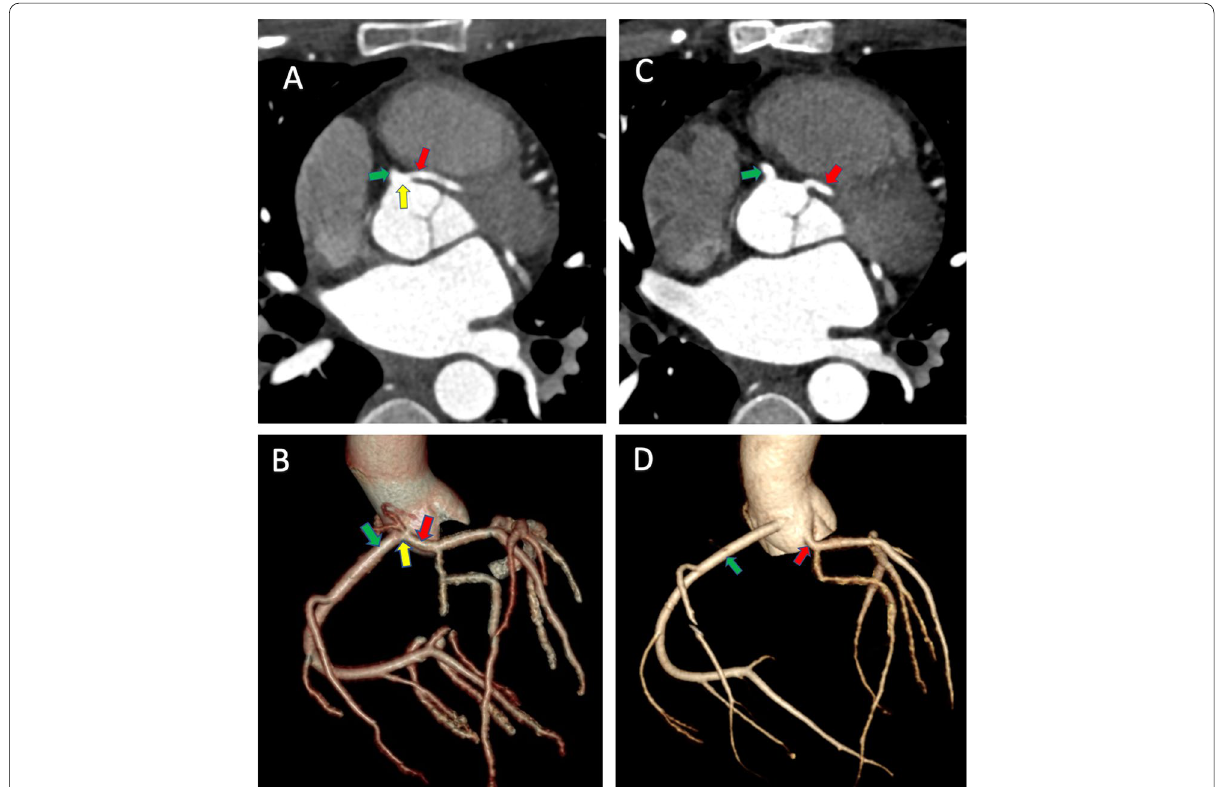
Fig. 2 Pre- and post-operative coronary CTA with 3D volume-rendered images. Coronary computed tomography angiography (CTA) demonstrates the single right coronary ostium (yellow arrow) giving rise to the left (red arrow) and right (green arrow) coronary arteries ( A and B ). Coronary computed tomography angiography (CTA) images postoperatively show the new origin of the left coronary artery (red arrows) which is now more posterior and inferior on the aortic sinus ( C and D ). The dominant right coronary artery (green arrows) is also